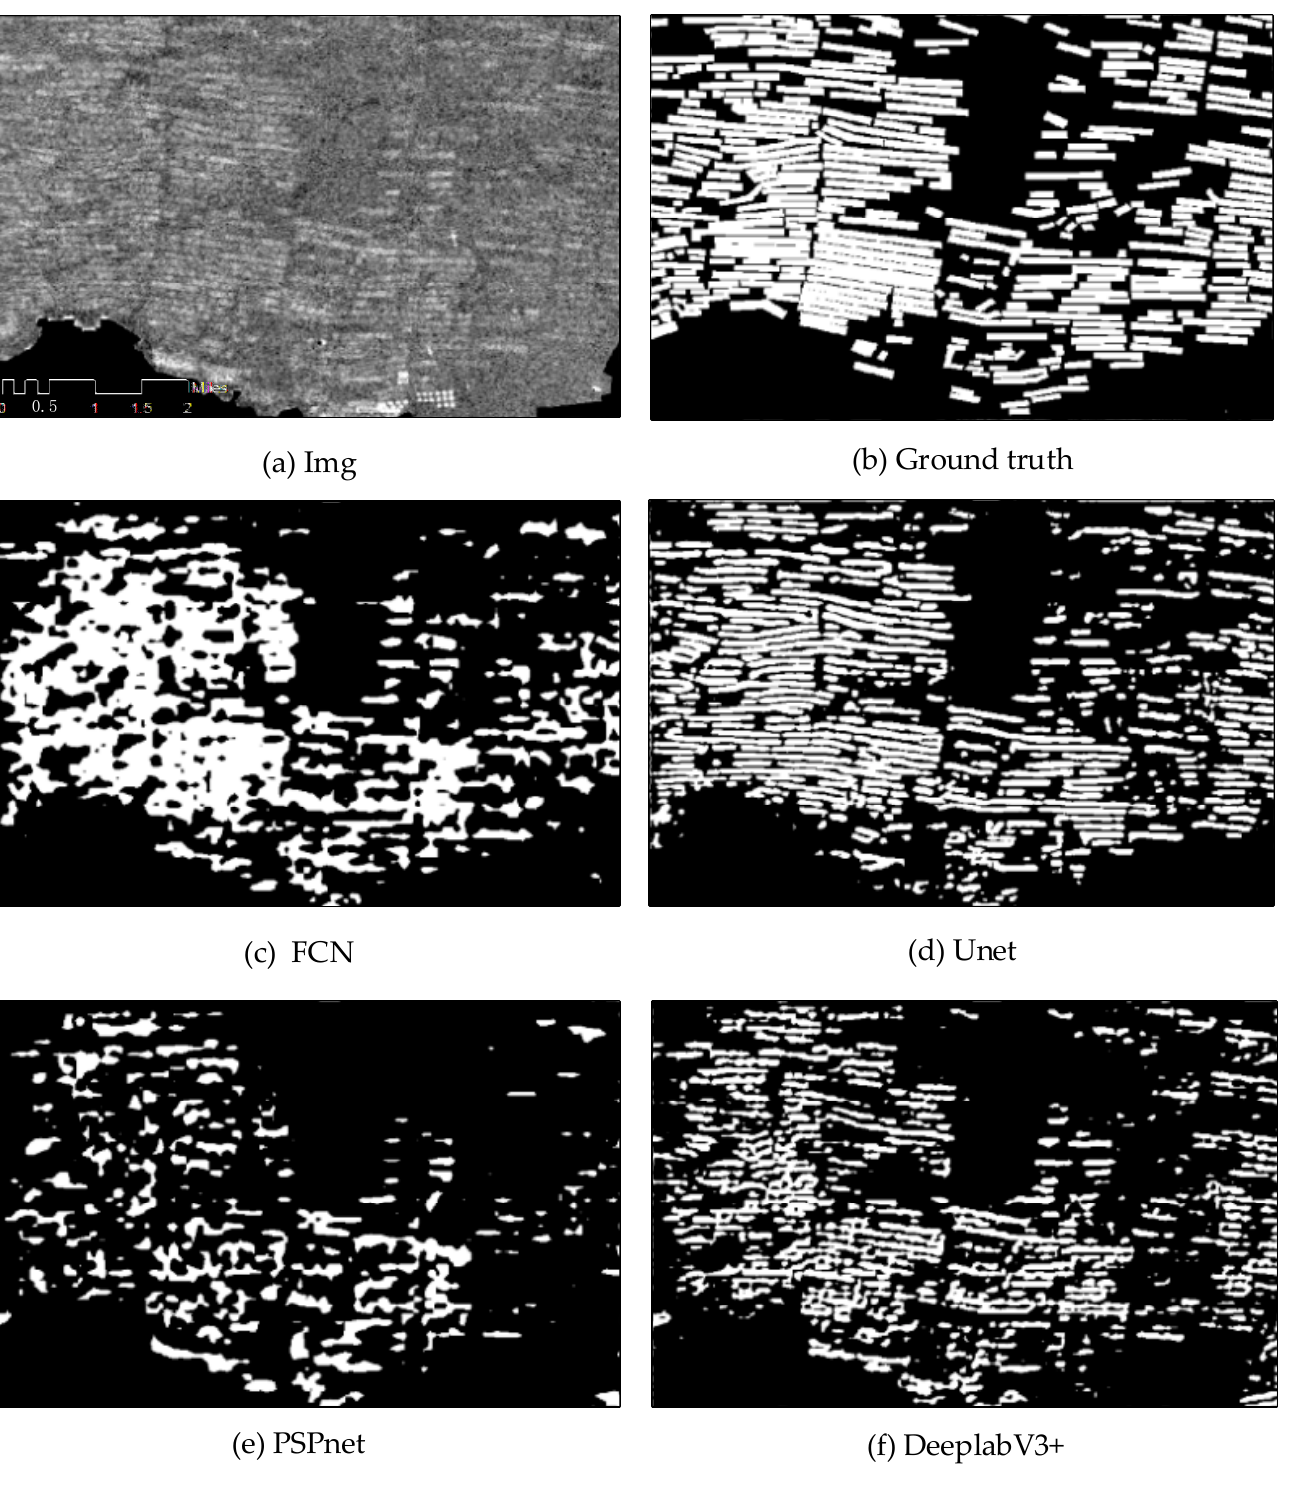
Figure 9. Visualization results of extraction for the marine raft aquaculture area by classical semantic segmentation models. ( a ) Test image (region numbered 0); ( b ) Ground truth; ( c )The result obtained by FCN; ( d ) The result obtained by Unet; ( e ) The result obtained by PSPnet; ( f ) is the result obtained by DeepLabV3+.